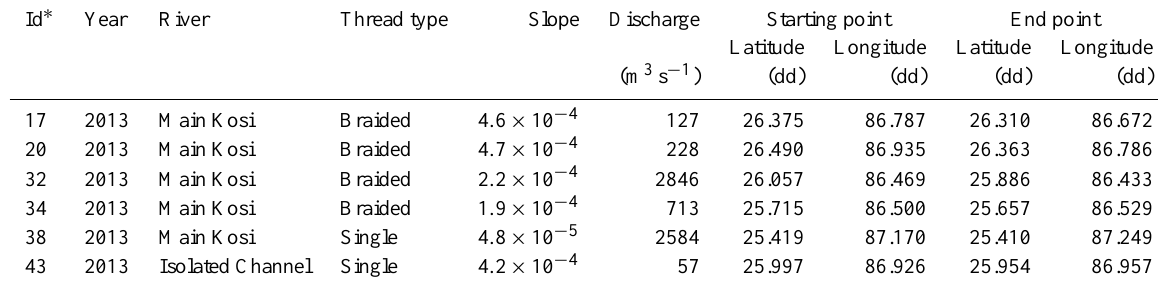
Table 4. Longitudinal water surface slope and corresponding water